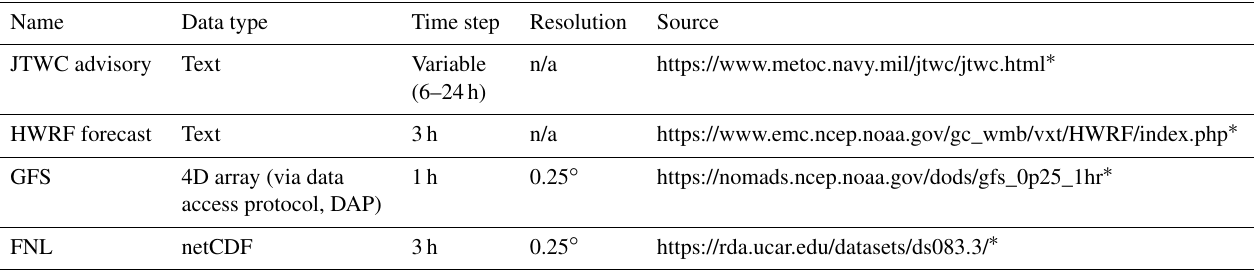
Table 1. Data sources for the model